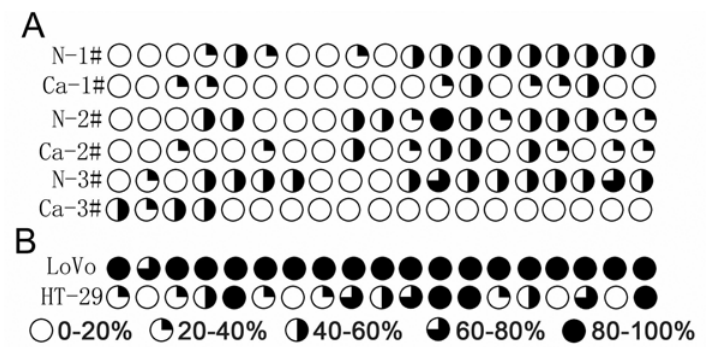
Fig 7. Genomic bisulfite sequencing of CpG methylation sites of PAR4 promoter in colorectal cancer tissues and cell lines. (A) PAR4 promoter methylation was analyzed in DNA from three colorectal cancer and their matched non-neoplastic tissues. (B) PAR4 promoter methylation in DNA from colorectal cancer cells lines, LoVo and HT-29. Average methylation at each analyzed CpG site in the PAR4 promoter is indicated based on bisulfite sequencing of 19 individual